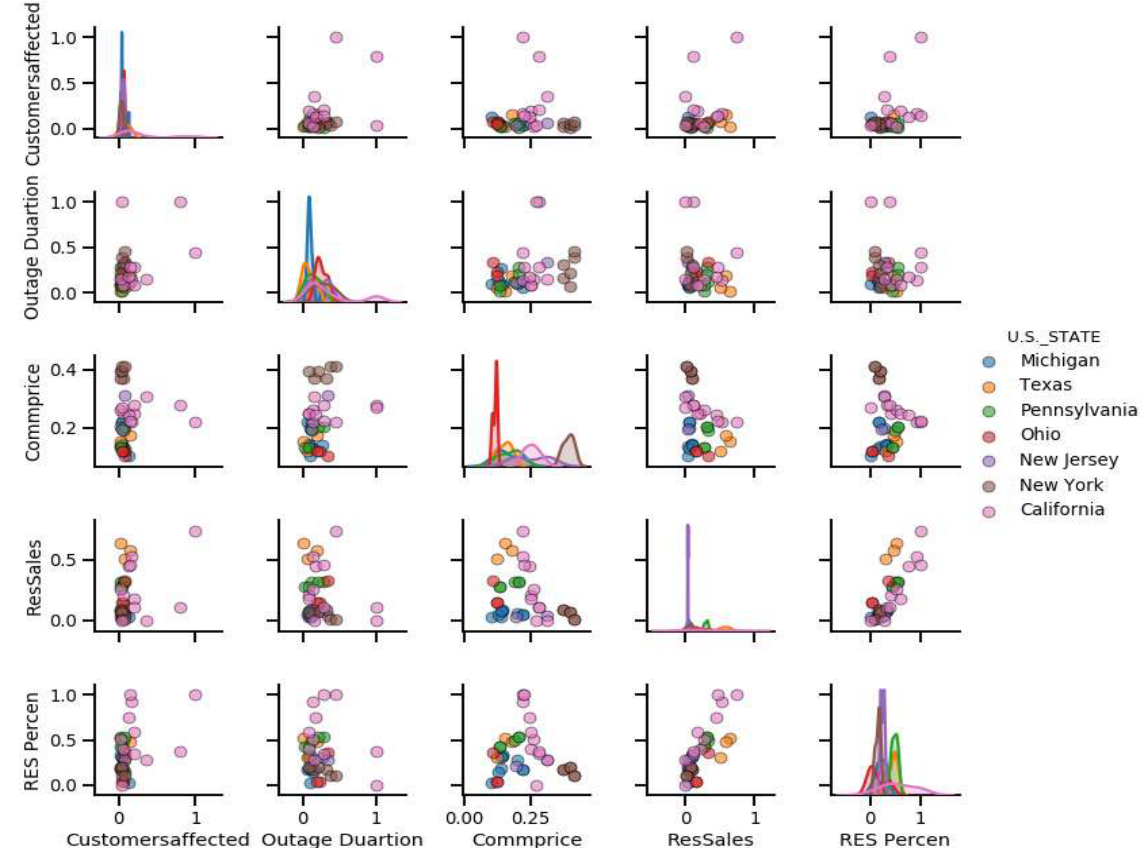
Figure 15. Top five feature correlation plots for the winter storm disaster category.